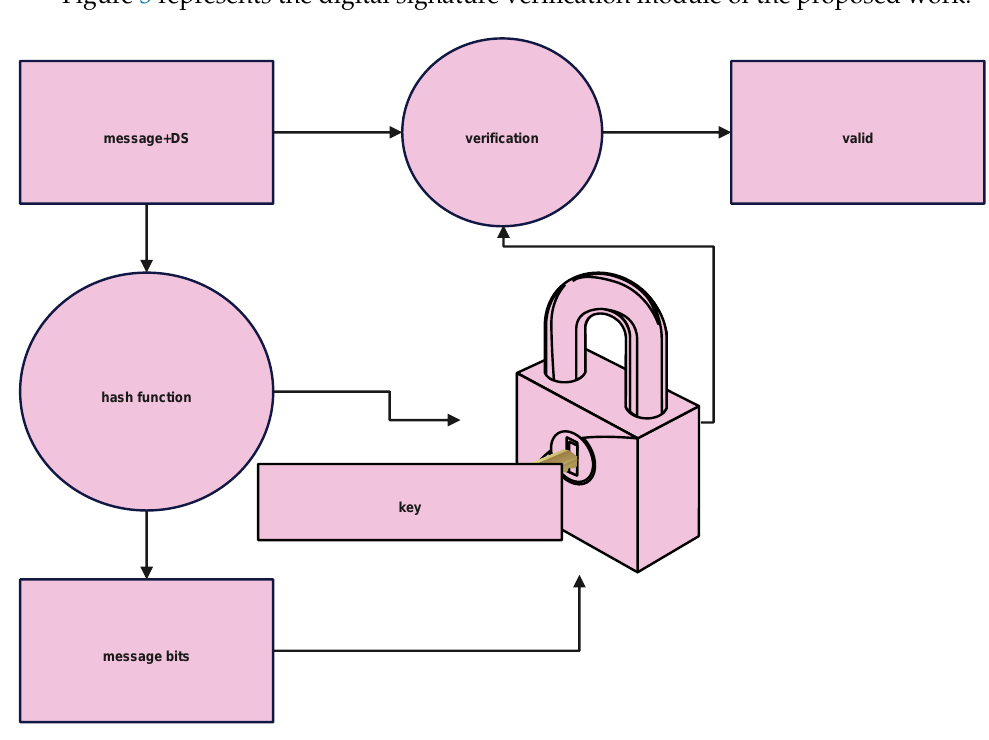
Figure 3. DFD of Digital Signature Verification Module shows the data flow diagram of Signature verification module in application RSAAPP.